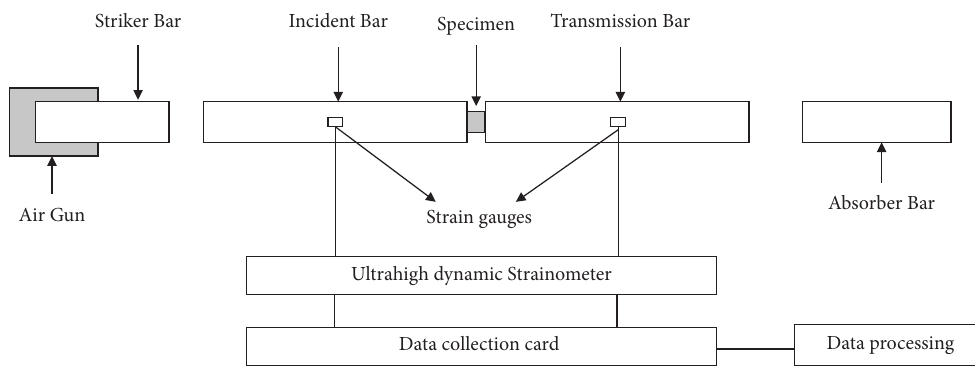
Figure 4: Schematic diagram of SHPB experimental